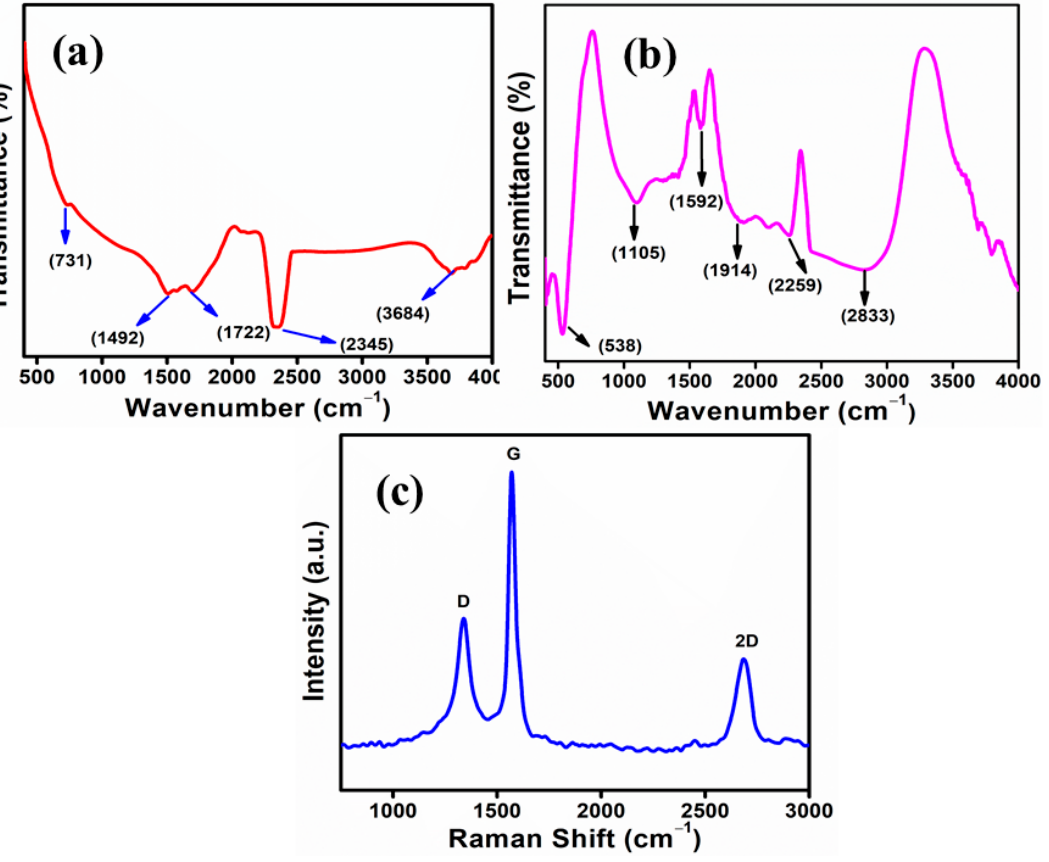
Figure 2. ( a ) FTIR spectra of graphene, ( b ) FTIR spectra of Fe 3 O 4 /Gr nanocomposite, and ( c ) RAMAN spectra of graphene. spectra of Table 1. Elemental composition of Fe 3 O 4 /Gr nanocomposite from SEM-EDX analysis. Element